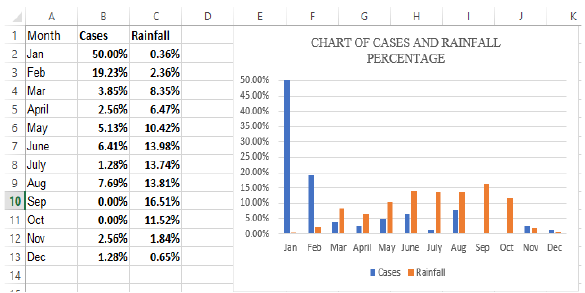
Figure 8. Chart showing the data and bar chart of cases and rainfall percentage